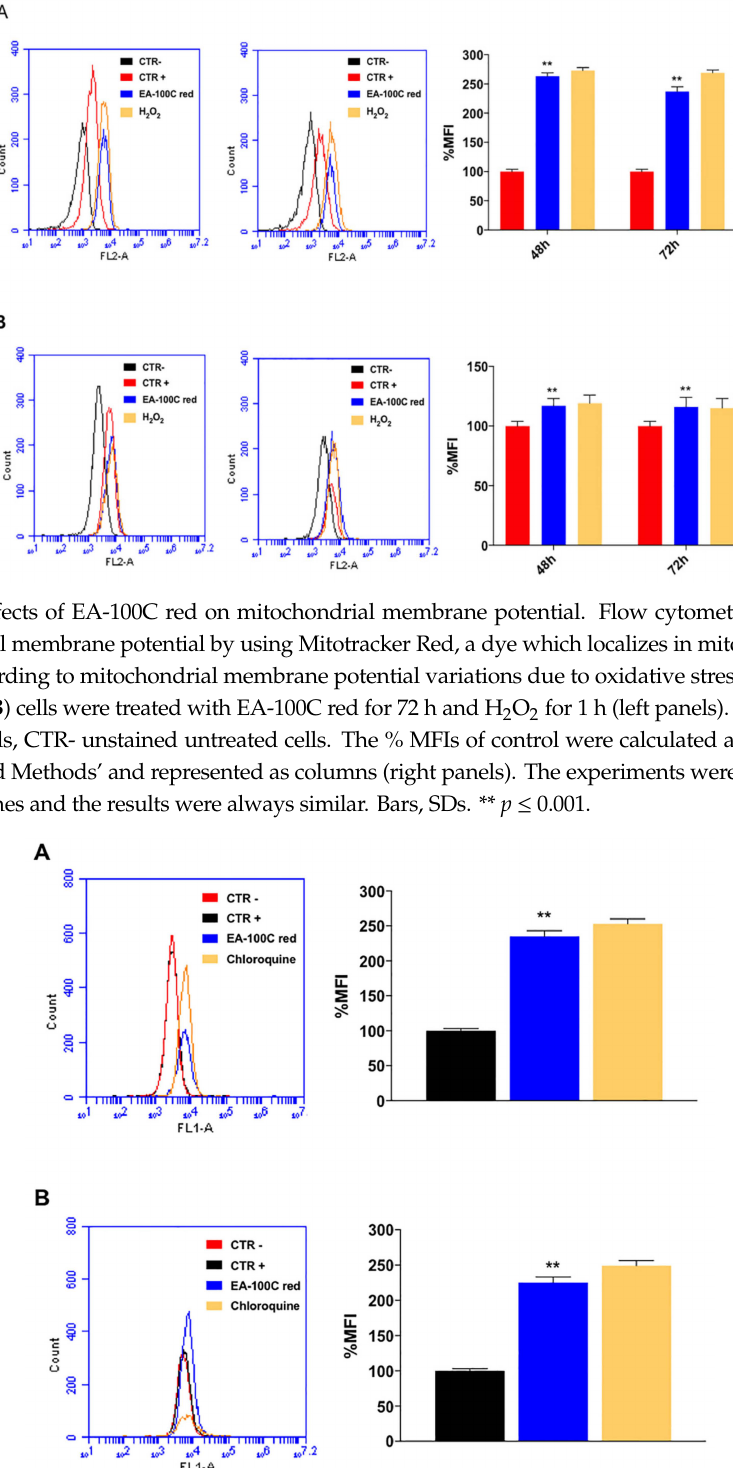
Figure 4. Effects of EA-100C red on autophagy. Flow cytometric analysis of autophagosome formation (MDC incorporation) in U87MG ( A ) and LN229 ( B ) cells treated with EA-100C red and chloroquine for 72 h (left panels). The % MFIs of control were calculated as described in ‘Materials and Methods’ and represented as columns (right panels). CTR + stained utreated cells, CTR- unstained untreated cells. The experiments were performed at least three times and the results were always similar. Bars, SDs. ** p ≤